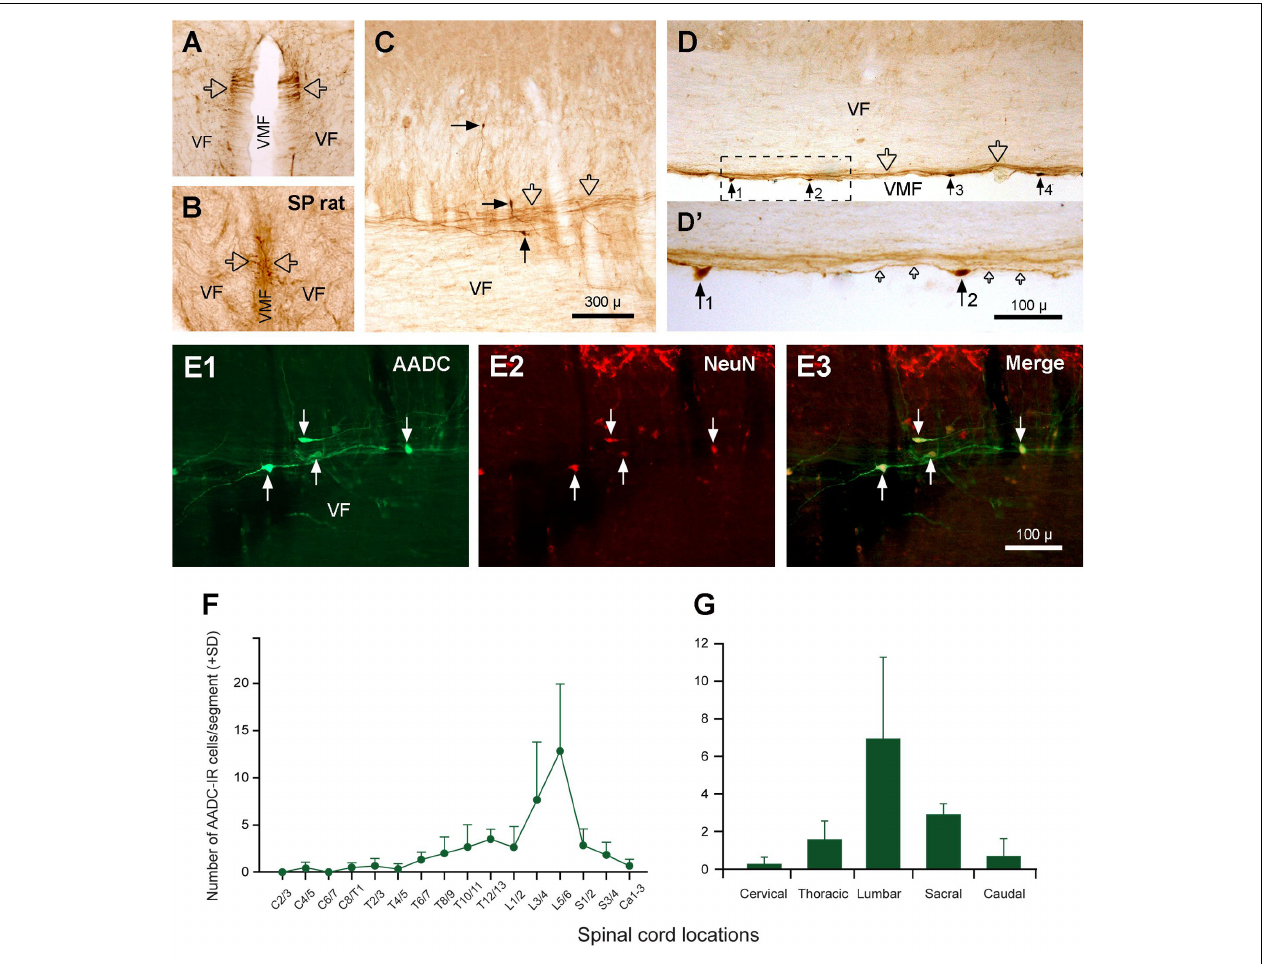
FIGURE 11 | Aromatic L -amino acid decarboxylase cells (neurons) and fibers in the VF along the VMF. (A) A transverse section at the first sacral level from a normal rat showing the AADC fibers in the VF close to VMF (hollow arrows). (B) A transverse section at the fourth sacral level from a 70-day S2 spinalized (SP) rat showing that the AADC fibers in this location persisted after spinal cord transection (hollow arrows). (C,D) AADC neurons (black arrows) and fibers (hollow arrows) in the VF close to the VMF in a parasagittal (C) and a horizontal (D) section. (D’) The enlargement of the area delimited by the dashed line in (D) . Four AADC cells (No. 1–4) were seen in (D) and it seems that all of the cells gave rise to fibers from their two ends and projected along the VMF (small hollow arrows in D’ ). (E1–E3) AADC cells in the VF were NeuN-IR, demonstrating their neuronal property. (F,G) Histograms showing the relative abundance of the AADC neurons in VF in relation to the spinal segments (F) and regions (G) (same format as Figure 10 ). It can be seen that the lumbar region, especially L5/6 segments, contained the highest density of the cells, the cervical region contained the lowest density of the cells, and the other regions were in between. AADC antibody was from rabbit. Scale bars in (C) , valid for (A–D) , 300 µ m; in (D’) , 100 µ m; in (E3) , valid for (E1–E3) , 100 µ